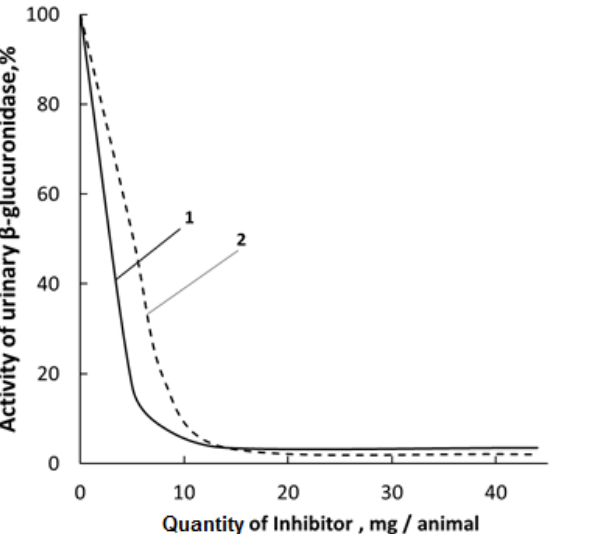
Figure 3. Comparison of activities of 1,4-glucarolactone and the polymer complex ag ainst β -glucu-